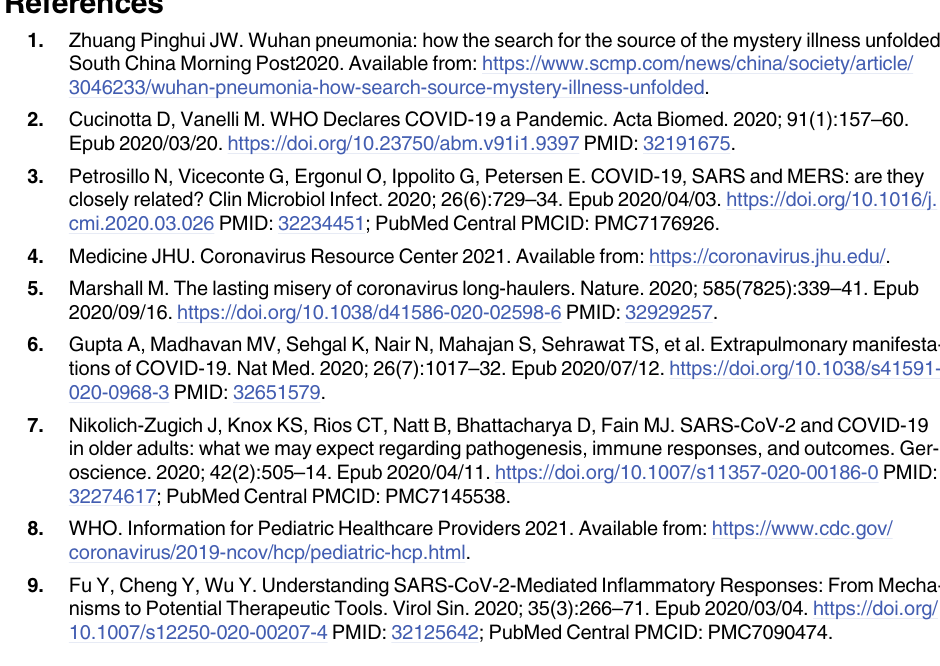
S2 Table. Statistical analysis of Extrapulmonary Tissue Gene Expression Analysis. qRT-PCR was performed on RNA extracted from mediastinal (M) lymph node, heart, kidney, spleen, liver, and large intestine from SARS-CoV-2 inoculated hamsters. Fold-change was cal- culated via ΔΔ Ct against baseline (Day 0) with BACT as the housekeeping gene (Fig 6). ANOVA was used to calculate statistical significance by comparing hamsters on the days post inoculation to baseline (day 0). No asterisk indicates a p-value > 0.05; � indicates a p-value < 0.05; �� indicates a p-value < 0.005; ��� indicates a p-value < 0.0005; ���� indicates a p-value < 0.0001. N is 3 for all